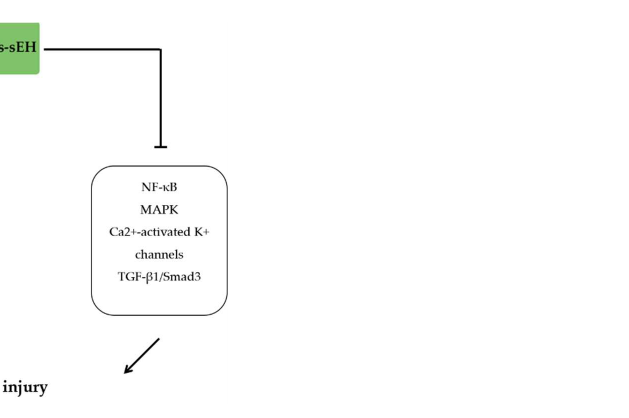
Figure 9. The anti-inflammatory effects of EETs in kidney injury. EETs ameliorate acute kidney in- jury by activating GSK3β, PI3K, mTORC, eNOS, and Sirt/FOXO3a signaling pathways and inhibit-